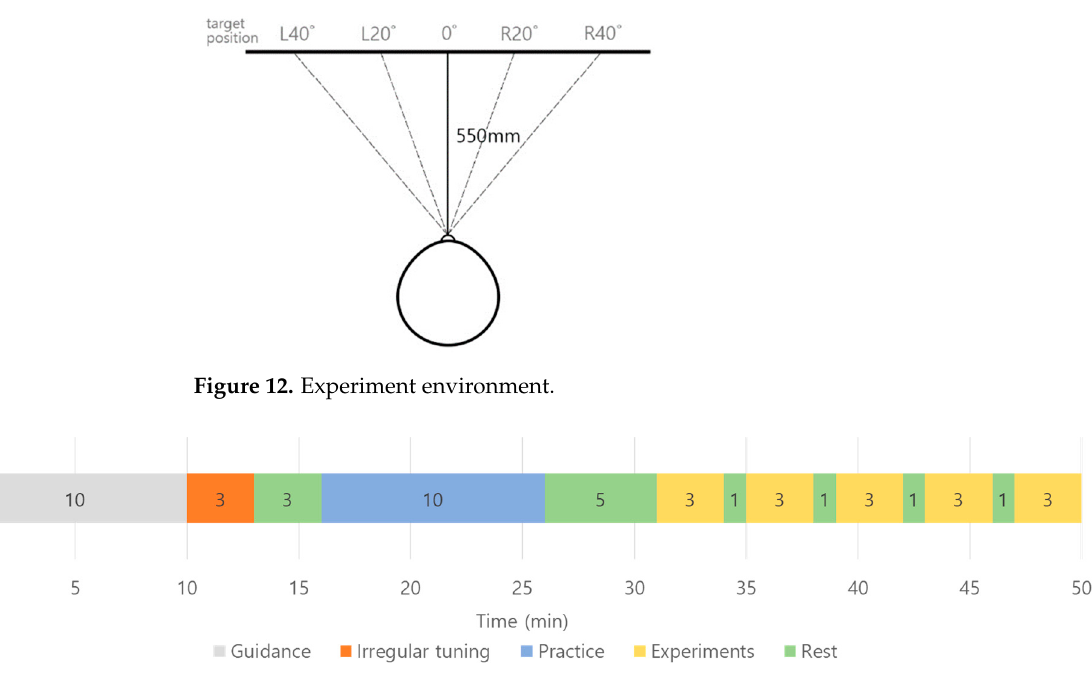
Figure 13. Timetable for virtual keyboard interface test.